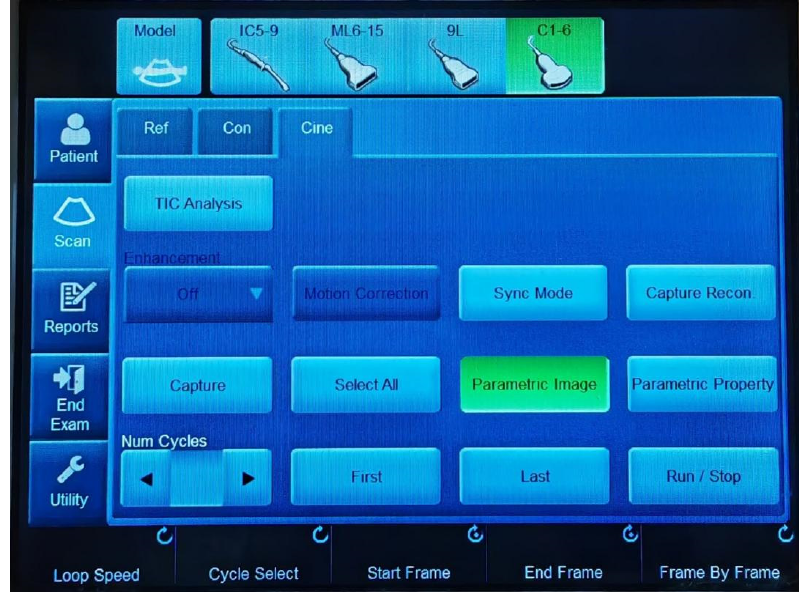
Figure 2. Parametric image button.